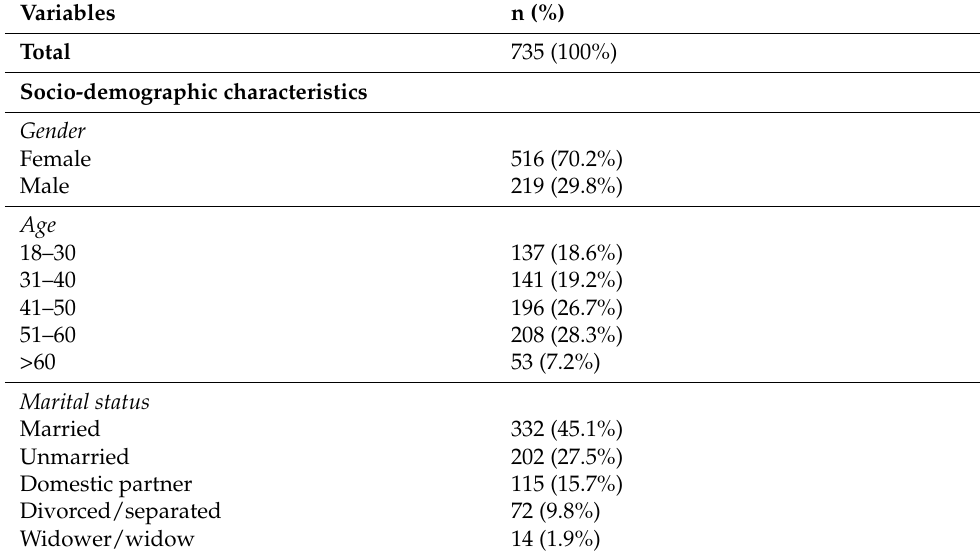
Table 1. Descriptive statistics of the sample